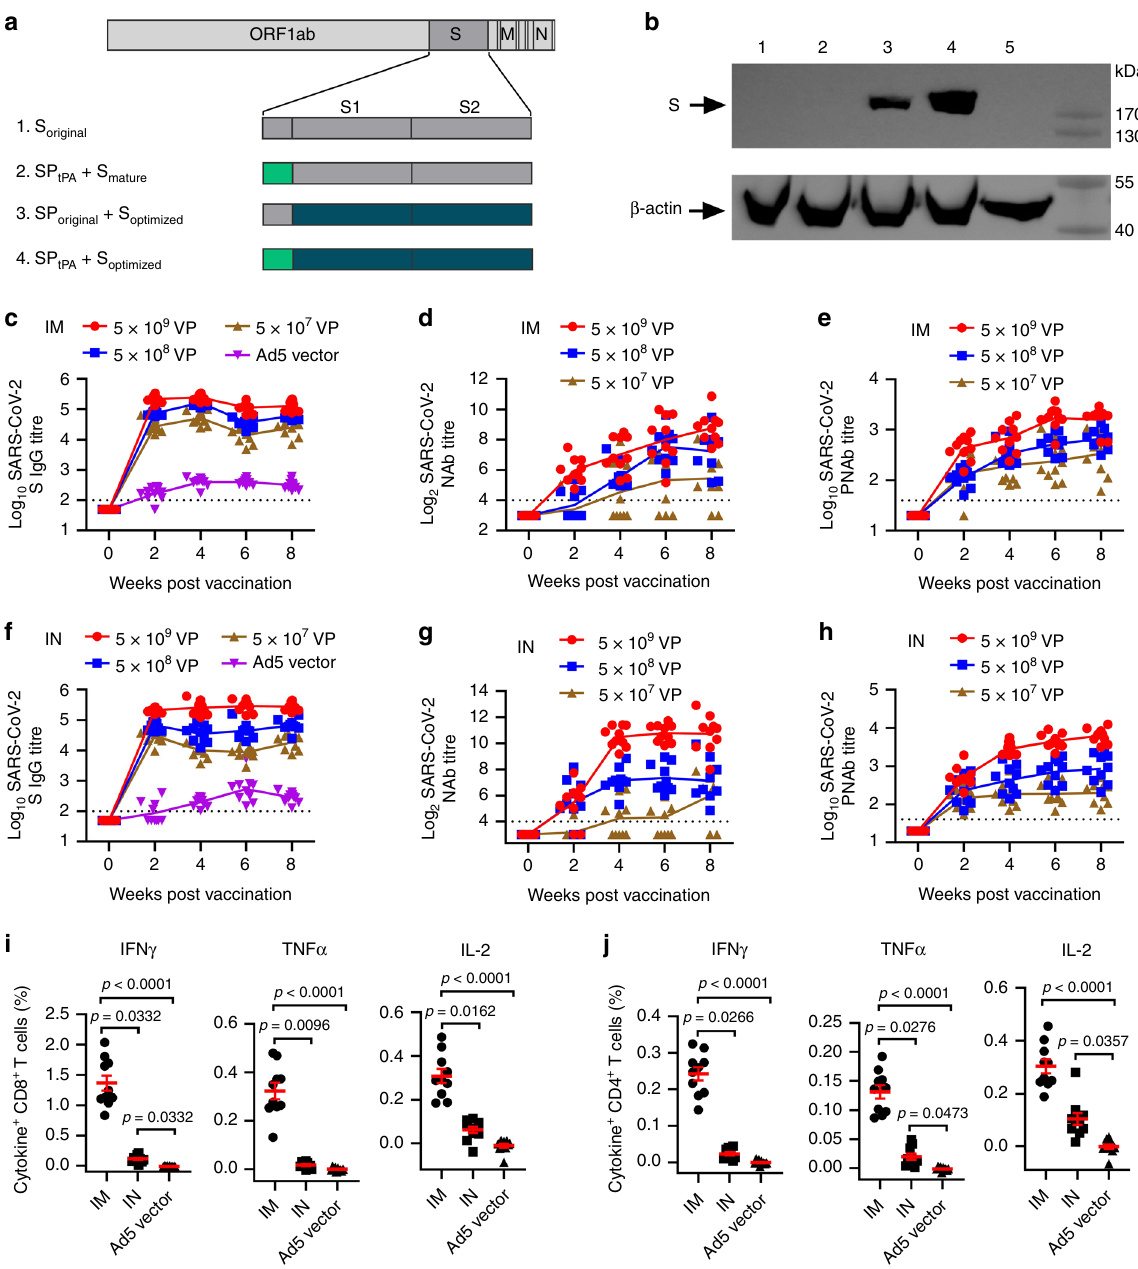
Fig. 1 Adenovirus-based vaccine design and immunogenicity in mice. a Schematic of SARS-CoV-2 S immunogens. b Western blot of transgene expression from (1) S original , (2) SP tPA add S mature , (3) SP original add S optimized , (4) SP tPA add S optimized , and (5) an empty plasmid transfected in HEK293 cells. BALB/c mice ( n = 10 per group) received a single immunization with different doses of Ad5-nCoV or Ad5 vector by the IM or IN route. c – h , Humoral immune responses were assessed at weeks 0, 2, 4, 6 and 8 following vaccination by S-speci fi c ELISA c , f , SARS-CoV-2 NAb titration (MN 50 ) d , g and SARS-CoV-2 PNAb titration e , h with n = 10 biologically independent animals per group. Data represent the individual titre of each animal and the connecting lines re fl ect the geometric means of the titres. i , j , Cellular immune responses were assessed at day 14 following vaccination in the 5 × 10 8 VP dose groups by intracellular cytokine staining assays with n = 10 biologically independent animals per group. Data are presented as mean ± s.e.m. Statistical signi fi cance was determined by Kruskal – Wallis ANOVA with Dunn ’ s multiple comparisons tests. S = spike protein, SP = signal peptide, tPA = tissue plasminogen activator. Dotted line = the limit of detection. Source data are provided as a Source Data fi